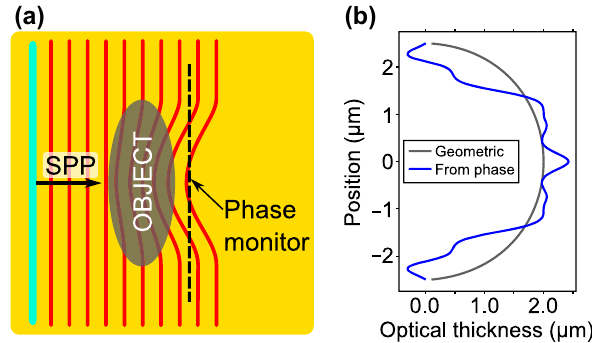
Figure 6: Proof-of-principle of near-field imaging of phase objects. (a) A scheme of a phase object with an incoming SPP ‘‘plane wave’’; dashed line located 500 nm behind the phase object represents a location where the phase delay is evaluated. (b) The geometric thickness of the phase object (black) compared to the thickness determined from the phase delay